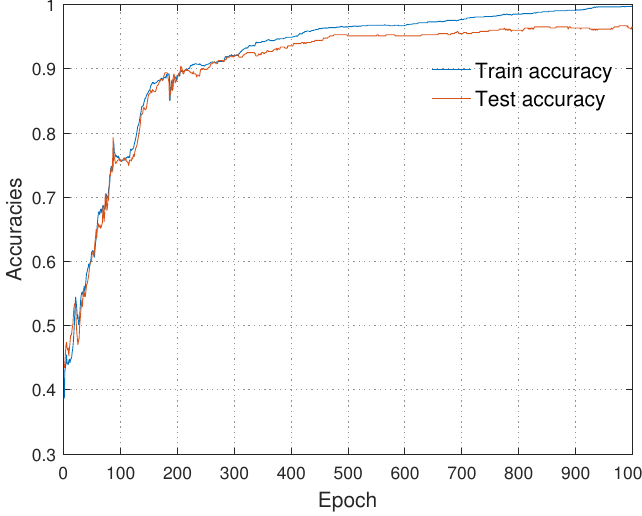
Figure 5. Train and test accuracy curves for the graph neural netwrok.